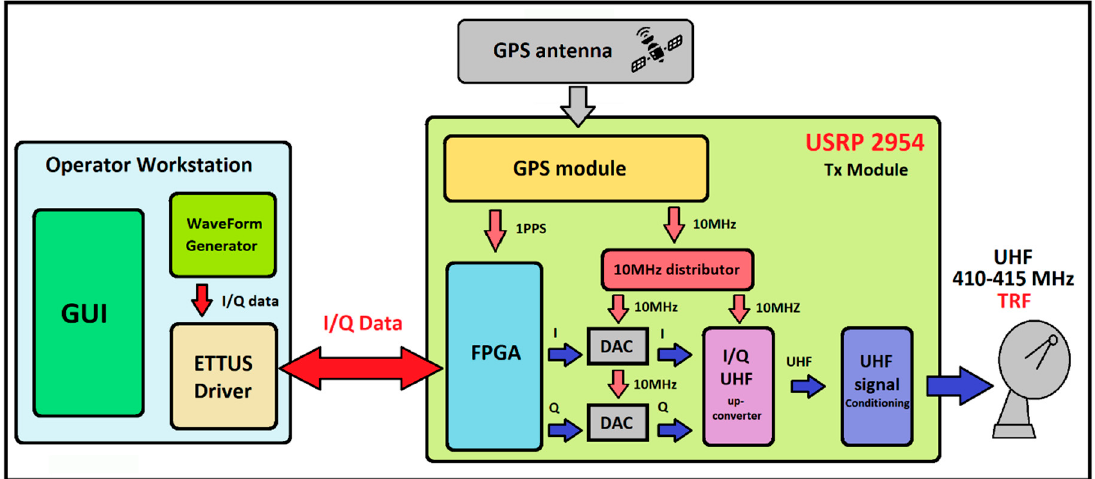
Figure 4. Transmitter architecture of the TRF antenna based on the USRP-2954R board.